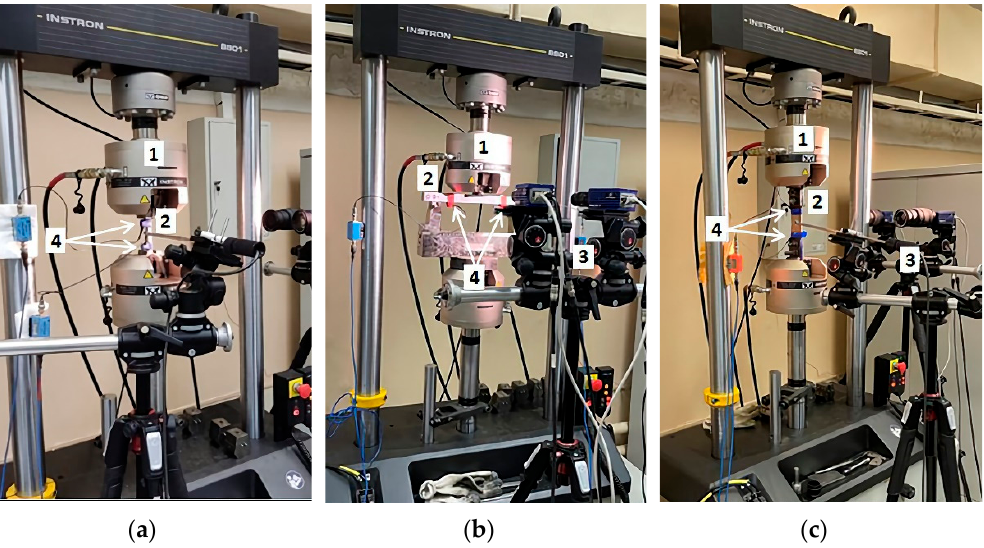
Figure 2. Experimental setup with rail ( a ), wheelset ( b ), and traction clamp ( c ) samples under in- spection: 1, loading device (punch); 2, inspected sample; 3, DIC system; 4, AE sensors.